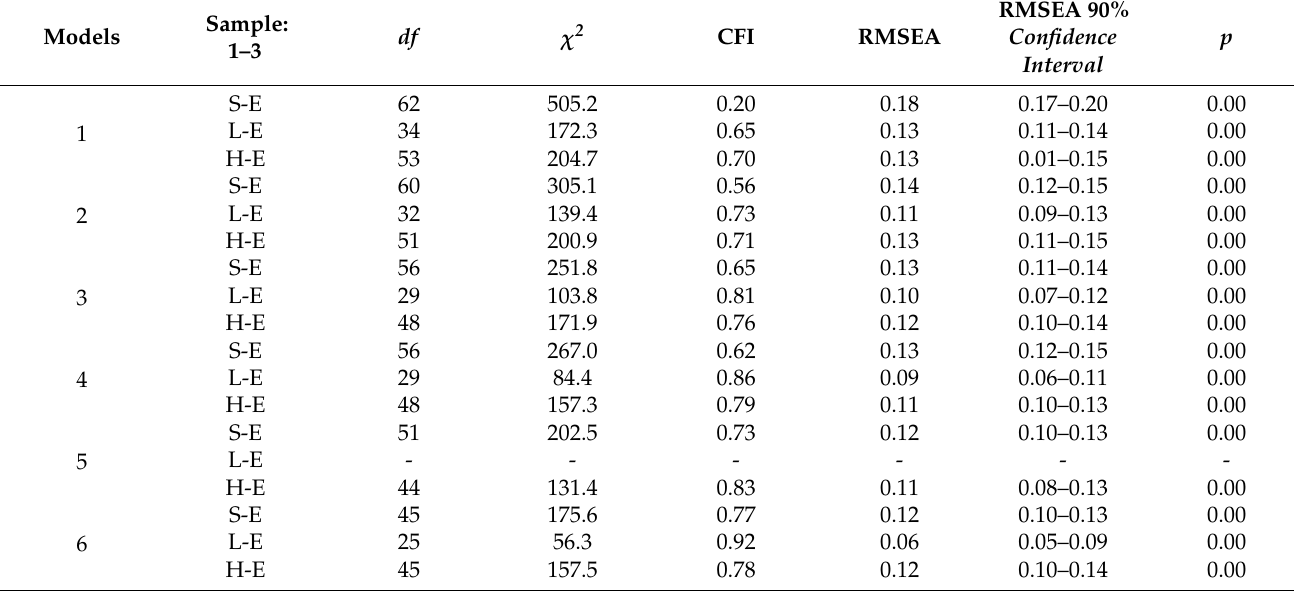
Table 4. Goodness of Fit Statistics for Three Samples’